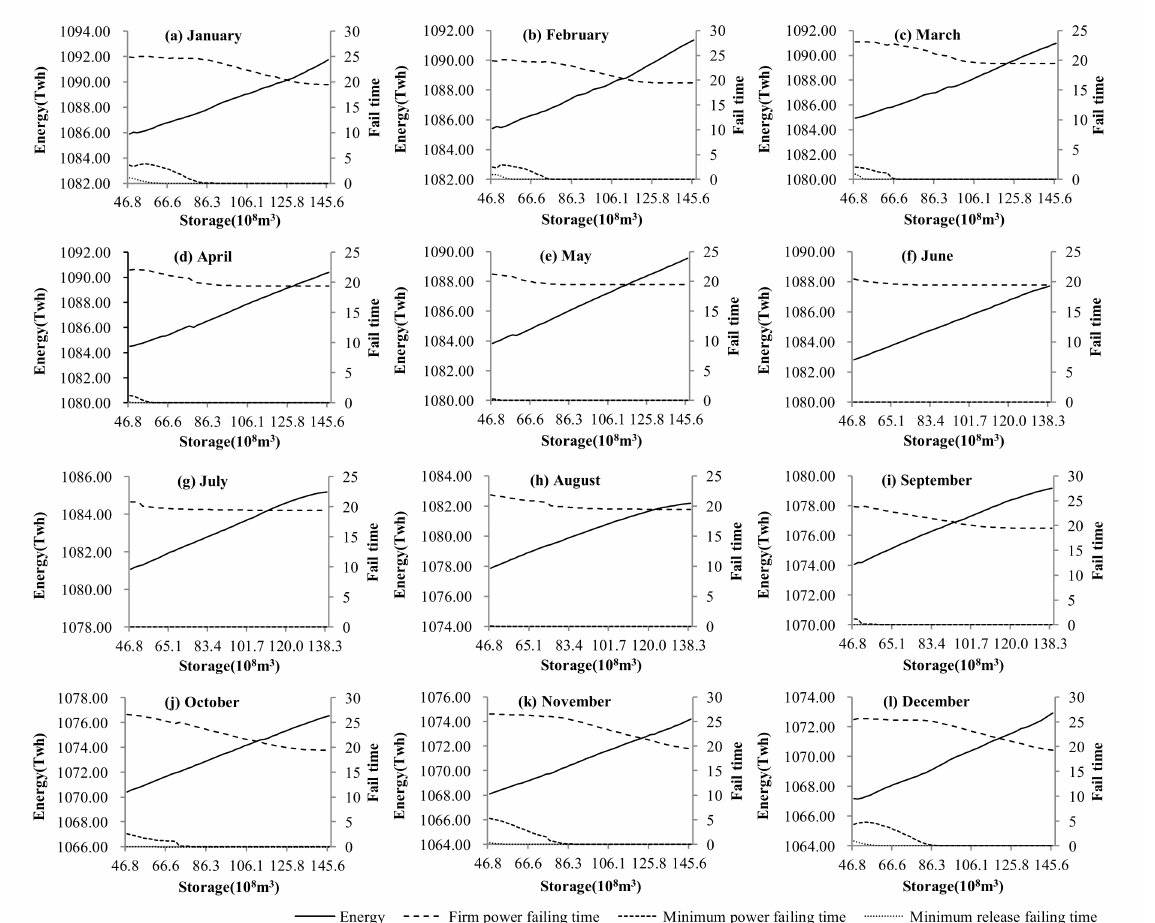
Figure 5. Failing chances and energy of